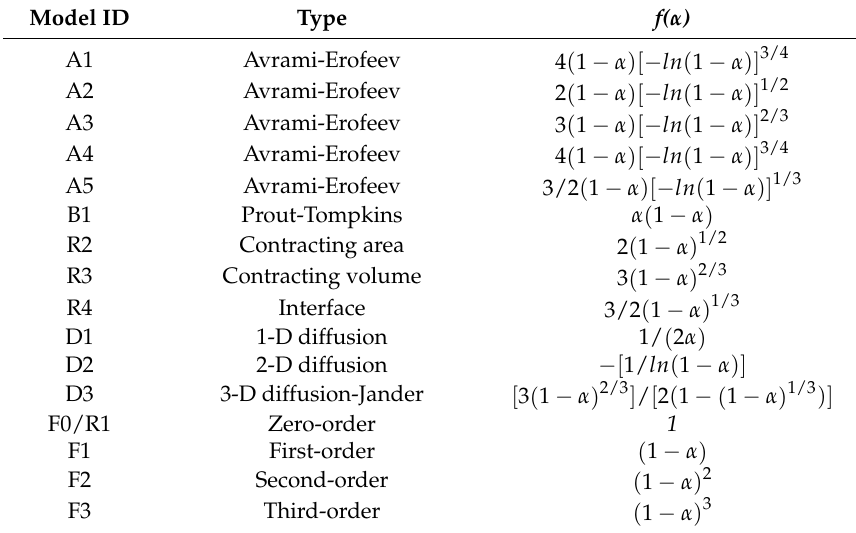
Table 2. Some models of solid-state reactions for conversion dependence [48,60,61].